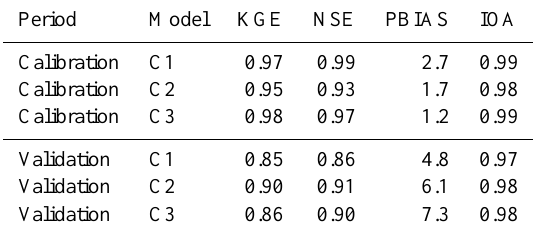
Fig. 7. SWE-C application with an hourly time time step at the Joe Figure 7. SWE-C application with hourly time time step in Joe Wrightstation.Thegraydotsarethemeasureddata,andgreen,red Wright station. The gray dots are the measured data, and green, red and blue solid lines are the modeled data by using C1, C2 and C3 and blue solid lines are the data modeled by using the C1, C2 and componentrespectively. C3 components, respectively.